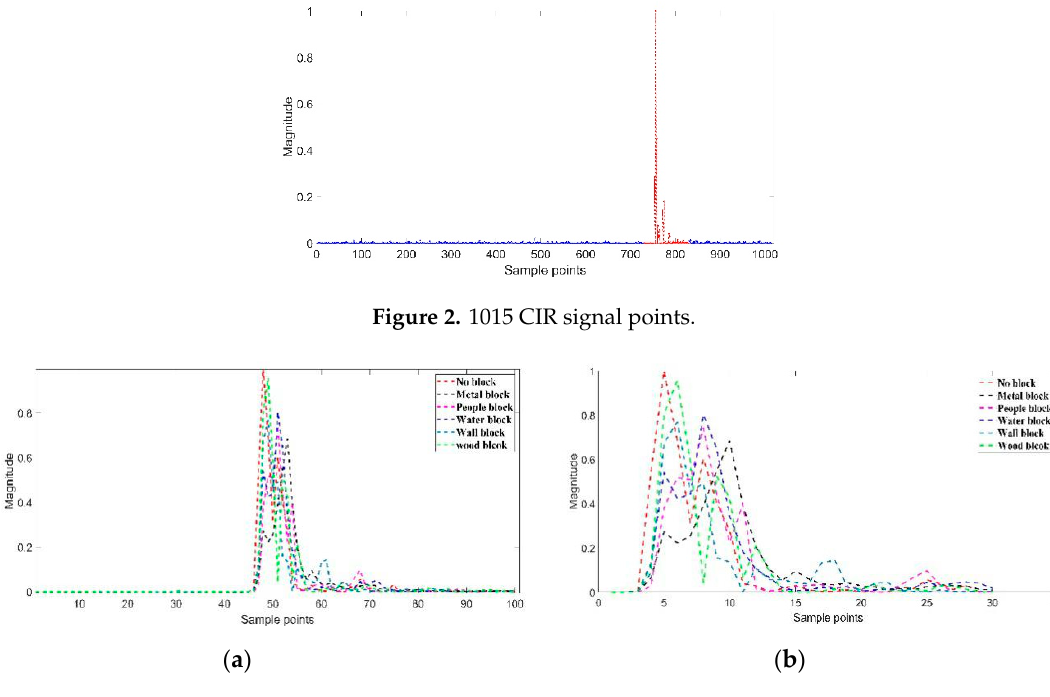
Figure 3. The different channel impulse response (CIR) signal points of 6 categories: ( a ) 100 CIR signal points of 6 categories; ( b ) 30 CIR signal points of 6 categories.